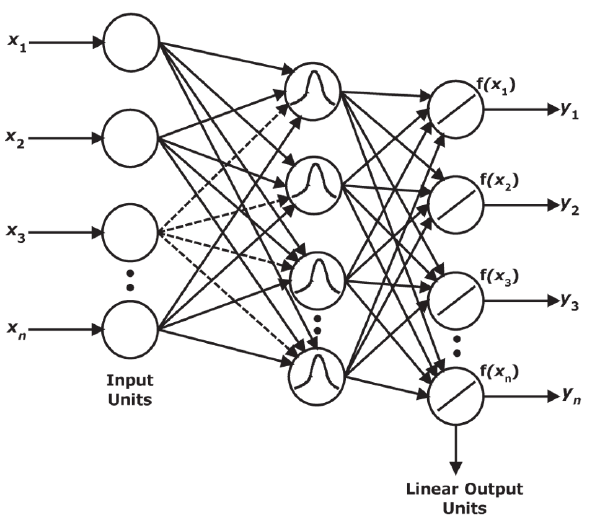
Fig. 4. Schematic diagram of RBNN